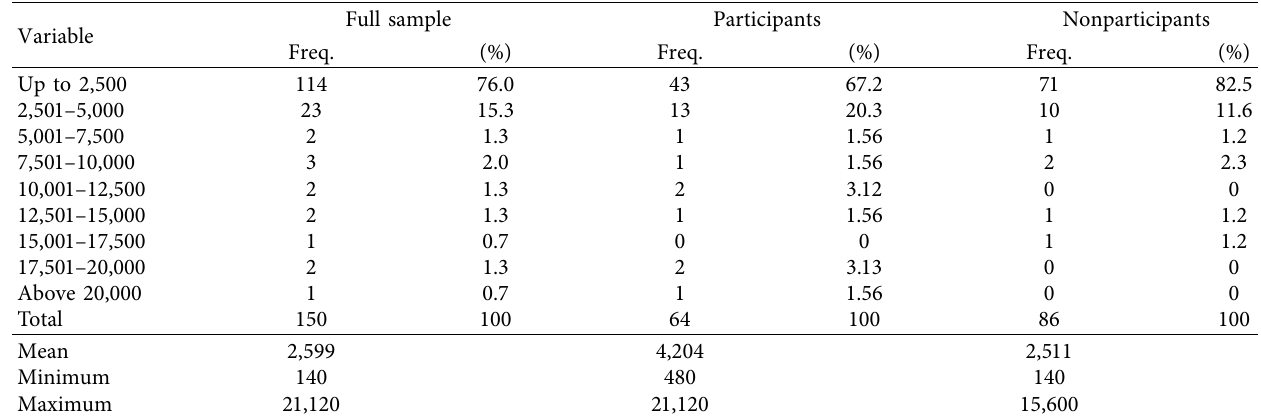
Table 3: Distribution of gross farm income of the respondents.